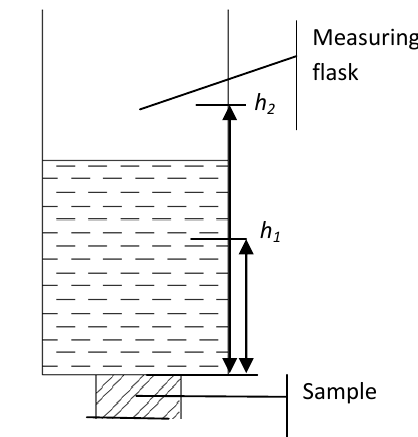
Figure 5. Set up for measuring the permeability of porous sample.